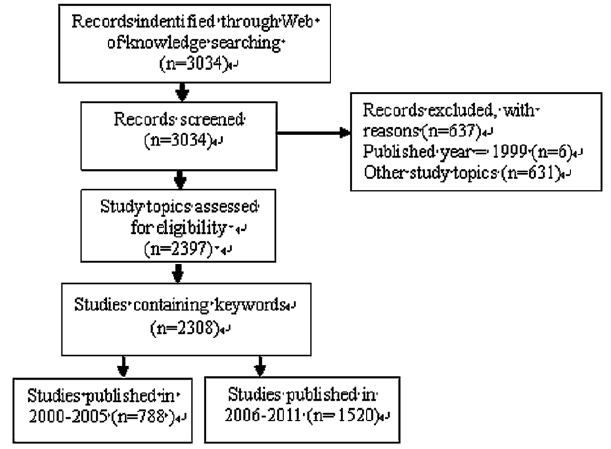
Figure 1. Study identification flow diagram for adherence research during